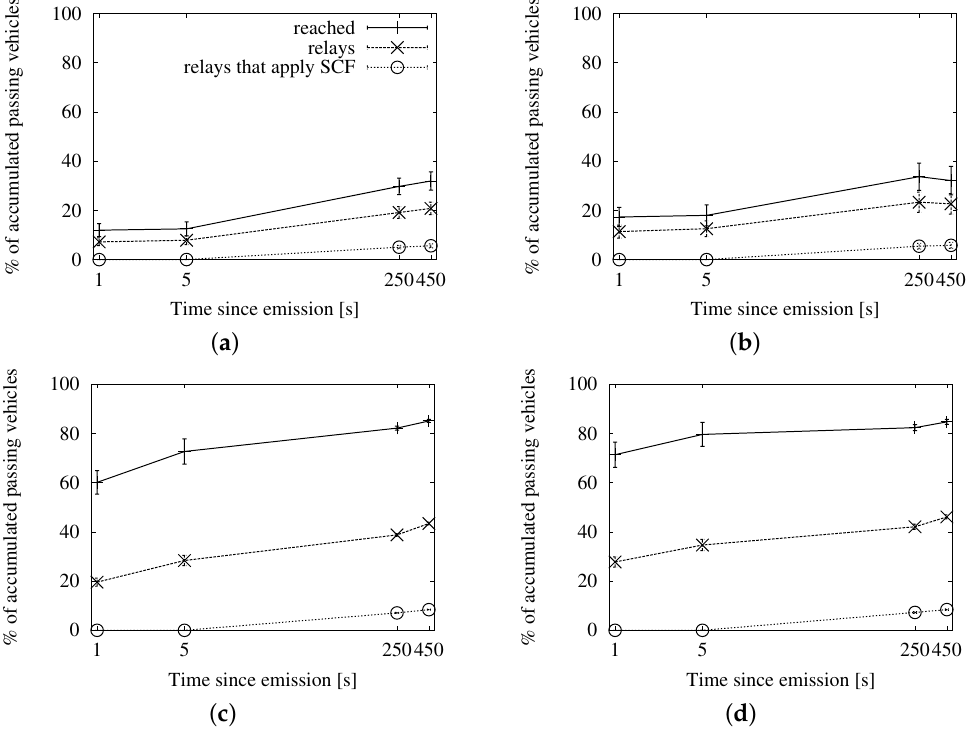
Figure 7. Involved vehicles with the speed-adaptive approach for store-carry-forward in the New York scenario: ( a ) roadway scheme, 25 vehicles/km 2 ; ( b ) map-based scheme, 25 vehicles/km 2 ; ( c ) roadway scheme, 100 vehicles/km 2 ; ( d ) map-based scheme, 100 vehicles/km 2